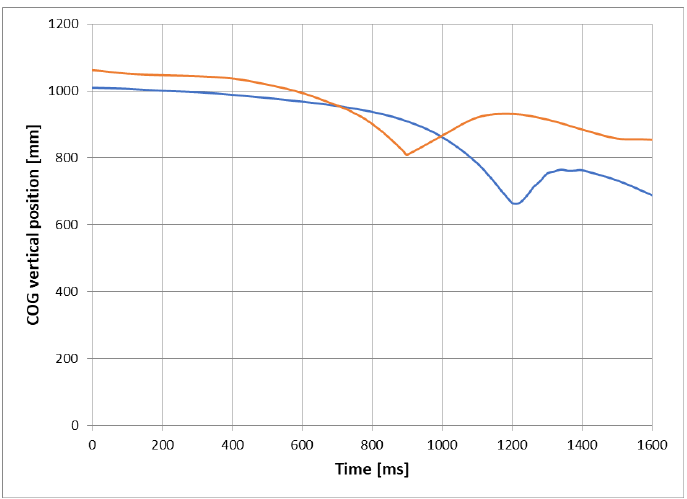
Figure 11. Actual COG vertical position for T1 ( blue line ) and T2 ( red line ) configurations during the rollover test.